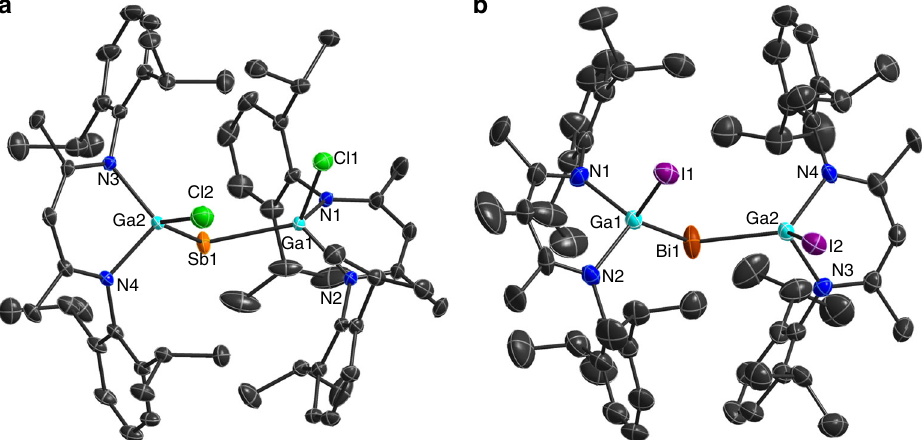
Fig. 3 Molecular structures of 1 and 4 . Molecular structures of 1 ( a ) and 4 ( b ) in the solids of 1 and 4 · 2C 7 H 8 . H-atoms were omitted for clarity, displacement ellipsoids are drawn at the 50% probability level. Selected bond lengths and angles: 1 , Ga – Sb 2.5899(4), 2.5909(3) Å, Ga – Sb – Ga 104.89(1)°; 4 , Ga – Bi 2.6640(9), 2.6663(9) Å, Ga – Bi – Ga 106.68(3)°